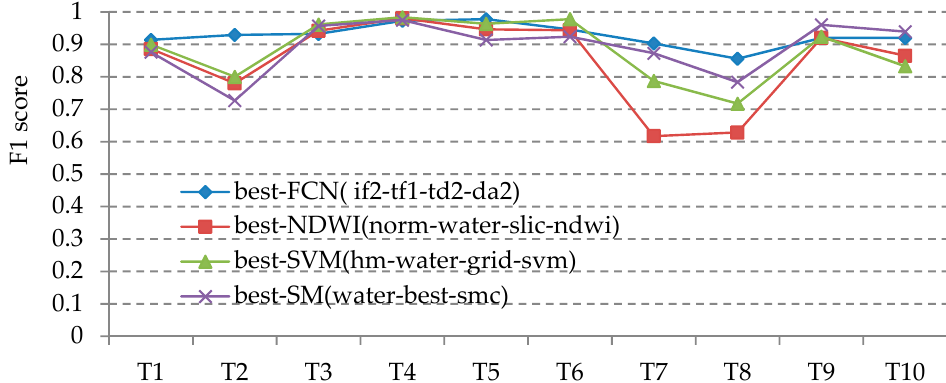
Figure 7. Comparison of best-FCN with best-SM, best-SVM, and best-NDWI in terms of per test data F1 score.